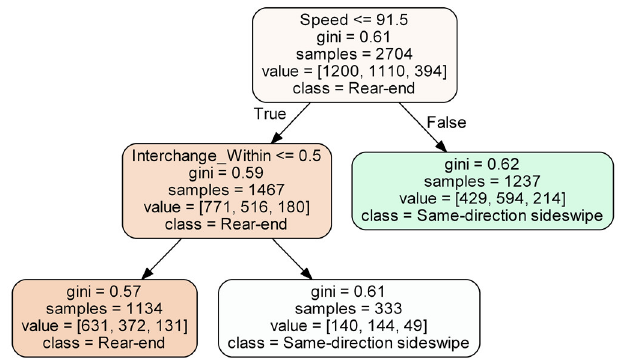
Figure 7. Illustration of a single decision tree for RTWE features.